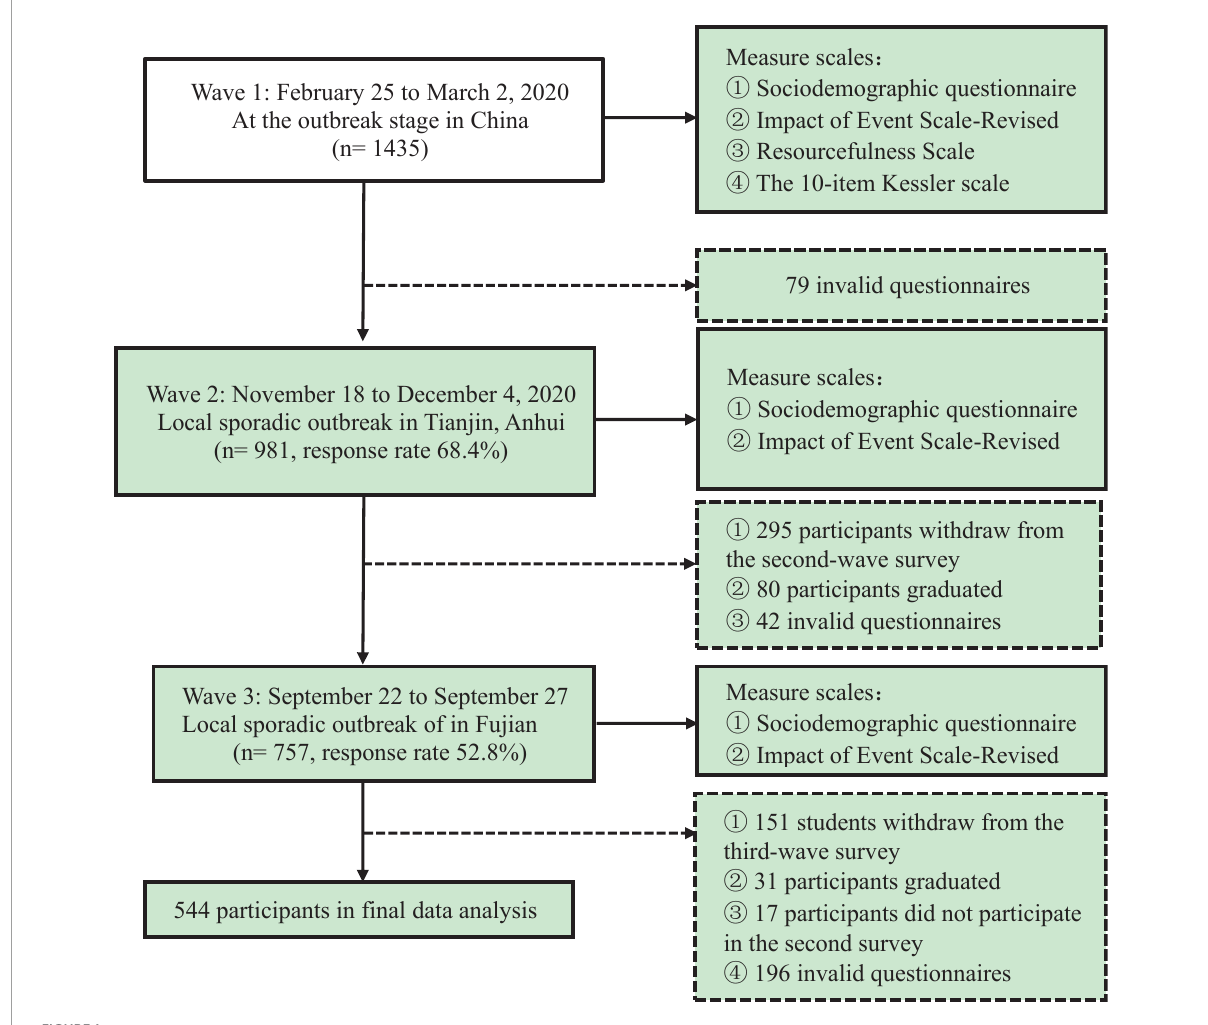
FIGURE1 Flow diagram of time, background, scales, sample size of three-wave